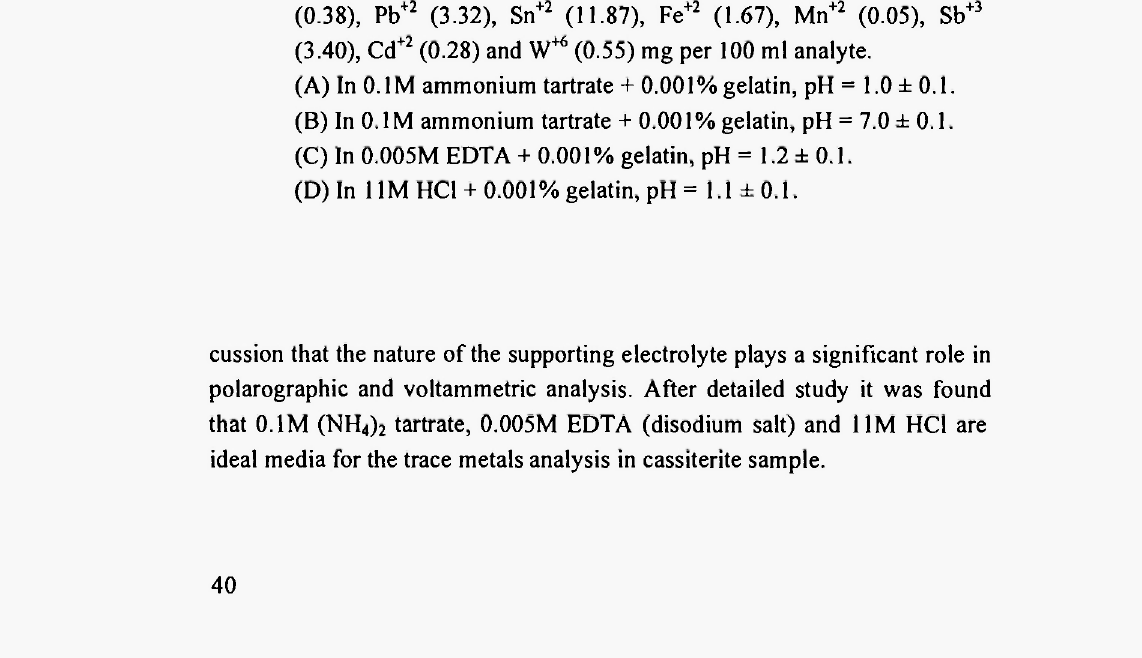
Fig. 5: Differential pulse polarogram of a synthetic sample containing Ti 44 (0.38), Pb +2 (3.32), Sn +2 (11.87), Fe +2 (1.67), Mn +2 (0.05), Sb +3 (3.40), Cd +2 (0.28) and W +6 (0.55) mg per 100 ml analyte. (A) In 0.1 Μ ammonium tartrate + 0.001% gelatin, pH = 1.0 ± 0.1. (B) In 0.1 Μ ammonium tartrate + 0.001% gelatin, pH = 7.0 ± 0.1. (C) In 0.005M EDTA + 0.001% gelatin, pH = 1.2 ± 0.1. (D) In UM HCl+ 0.001% gelatin, pH = 1.1 ±0.1.